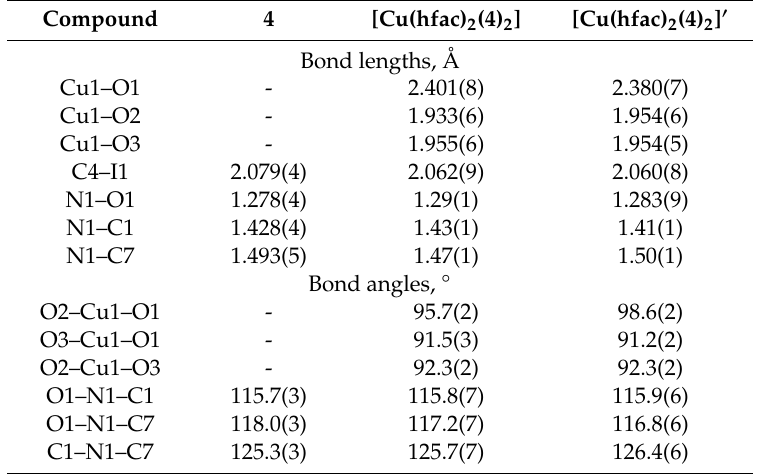
Table 2. Selected geometrical parameters for 4 and [Cu(hfac) 2 ( 4 ) 2 ] (two independent